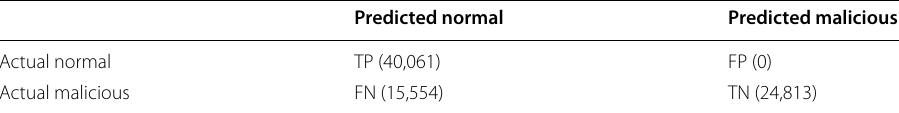
Table 16 Confusion matrix of SVM